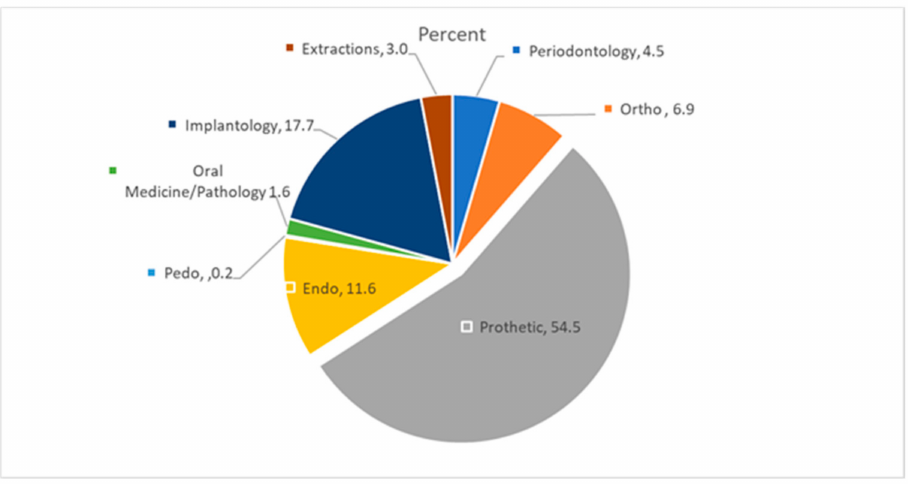
Figure 1. The purpose of the claim as a function of the primary treatment